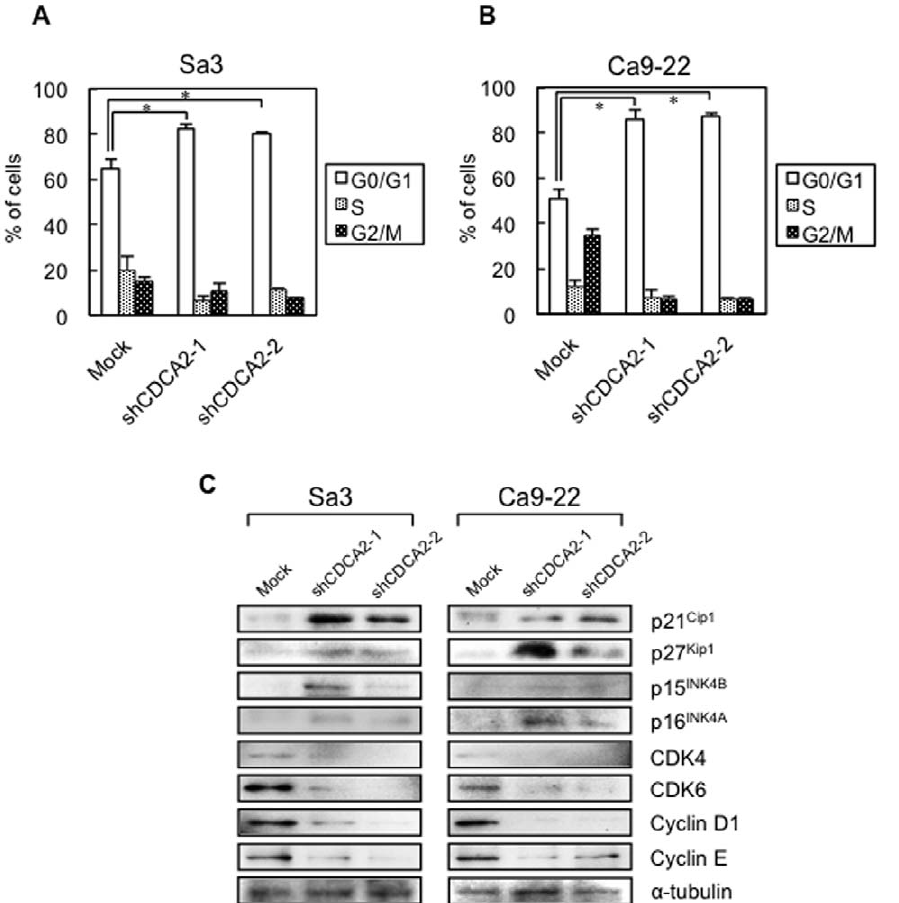
Figure 3. Flow cytometric determination of DNA content and expression of cell-cycle regulators in shCDCA2-transfected cells. We analyzed the flow cytometric determination of DNA content by a FACScalibur in the G0-G1, S, and G2-M phases. We then determined the